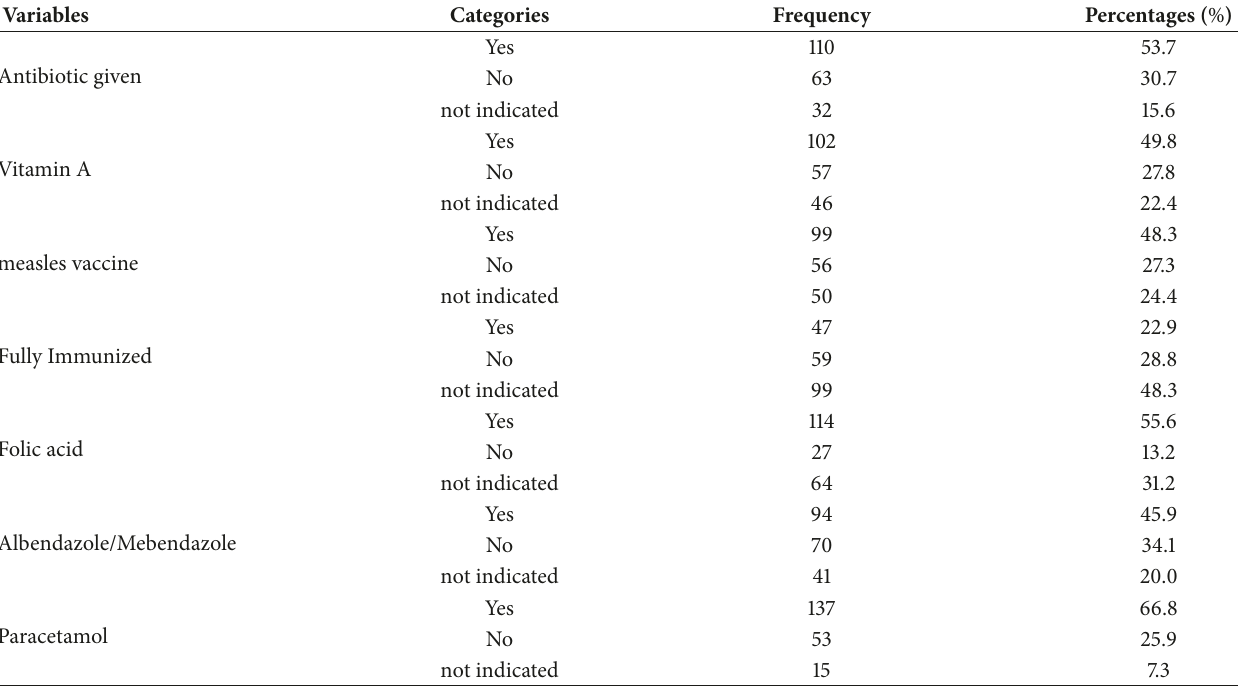
Table 3: Distribution of treatment given information on treatment outcome for children with SAM admitted to NRH, West Ethiopia, from November 2015 to April 2017